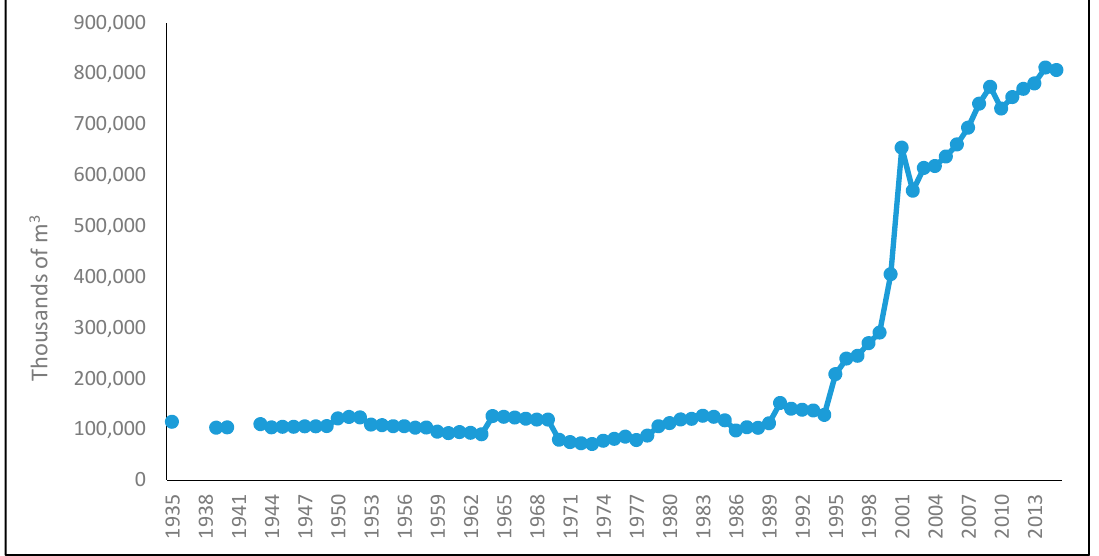
Figure 3. Evolution of the blue water footprint of wine in Spain, 1935–2015. Source: Own calculation based on data of Anuario Estadístico de la Producción Agraria [56].